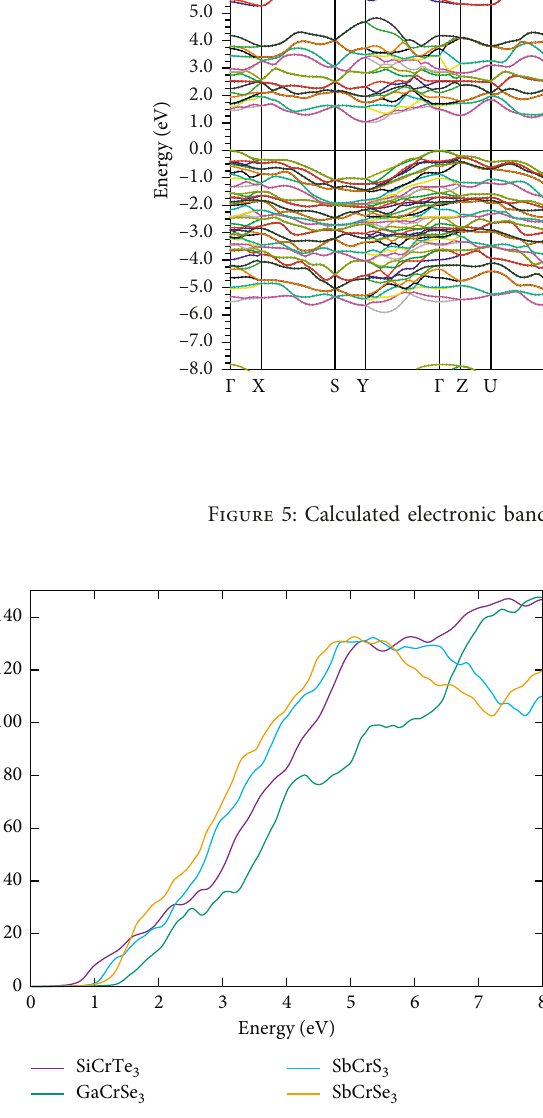
Figure 6: Calculated optical absorption spectra for semiconductor chromium